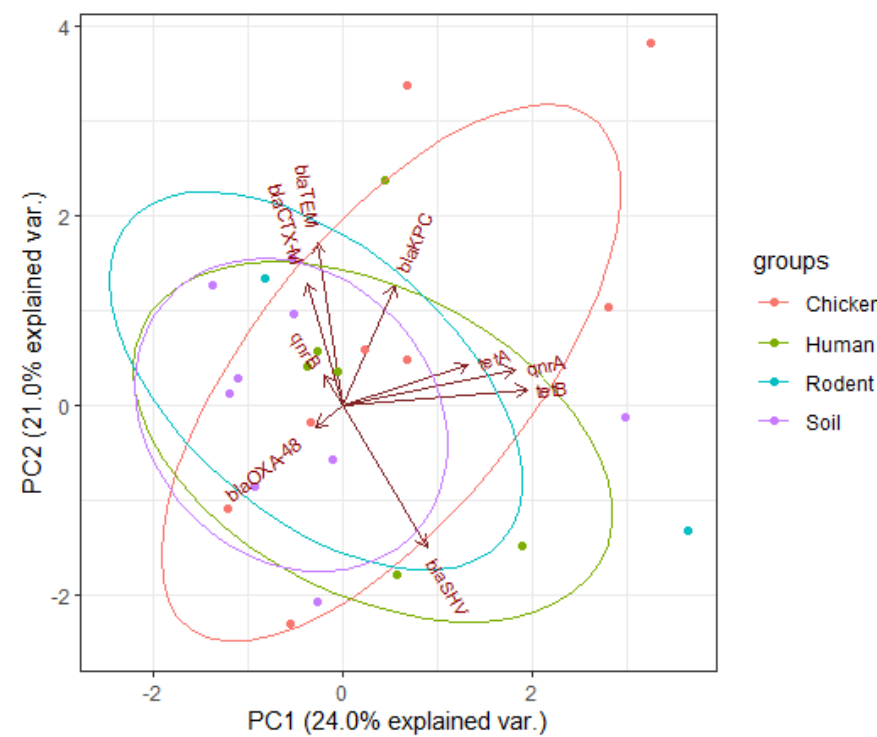
Figure 6. Principal component analysis of resistance genes of E. coli isolates. The dots represent isolates from different sources of samples, arrows indicate the original variables (resistance genes of the isolates), and ellipses indicate a region that contains 95% of all samples of a particular source. The smaller angle between traT gene vector and PC1 indicates a greater and positive correlation between them (Figure 7). The same behaviour was displayed by east and eae genes which show a greater and positive correlation between them. Along PC2, stx-1 , bfp and ompA genes had greater and positive correlations with PC2 indicating higher influence on virulence of isolates. The different sizes of loadings indicated higher and positive correlations between them. Different sizes of ellipses indicate variation in the prevalence of virulence genes across different sources of isolates. Rodent isolates had more virulence genes followed by chicken and soil isolates, while those from humans had the lowest gene